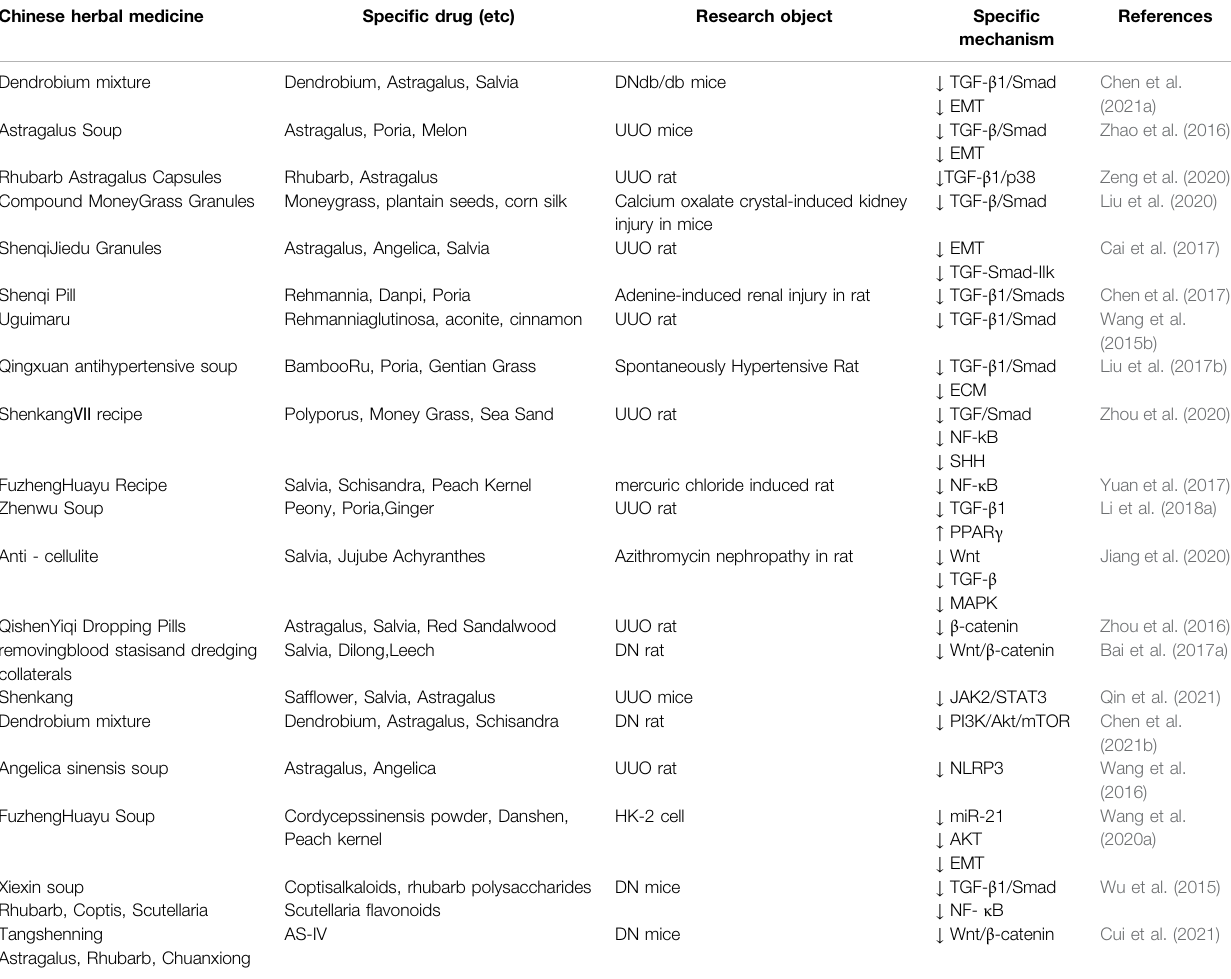
TABLE 3 | Summary of Chinese herbal medicines that improve RIF-related mechanisms Compound and Compound extract. Chinese herbal